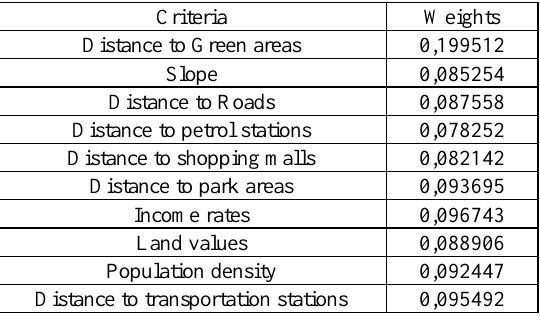
Table 1. Criteria weights